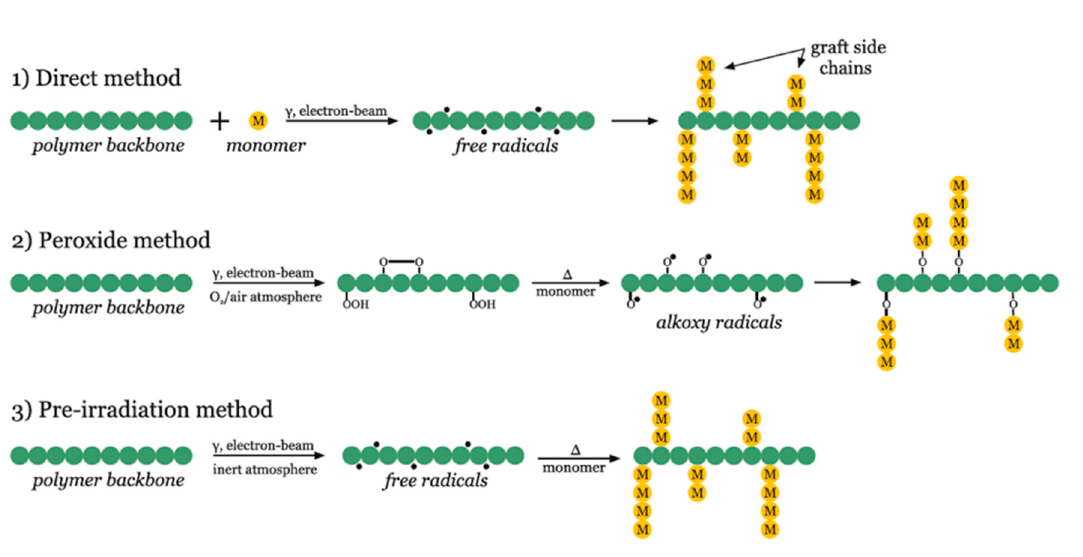
Scheme 8. Scheme of radiation-induced grafting methods for